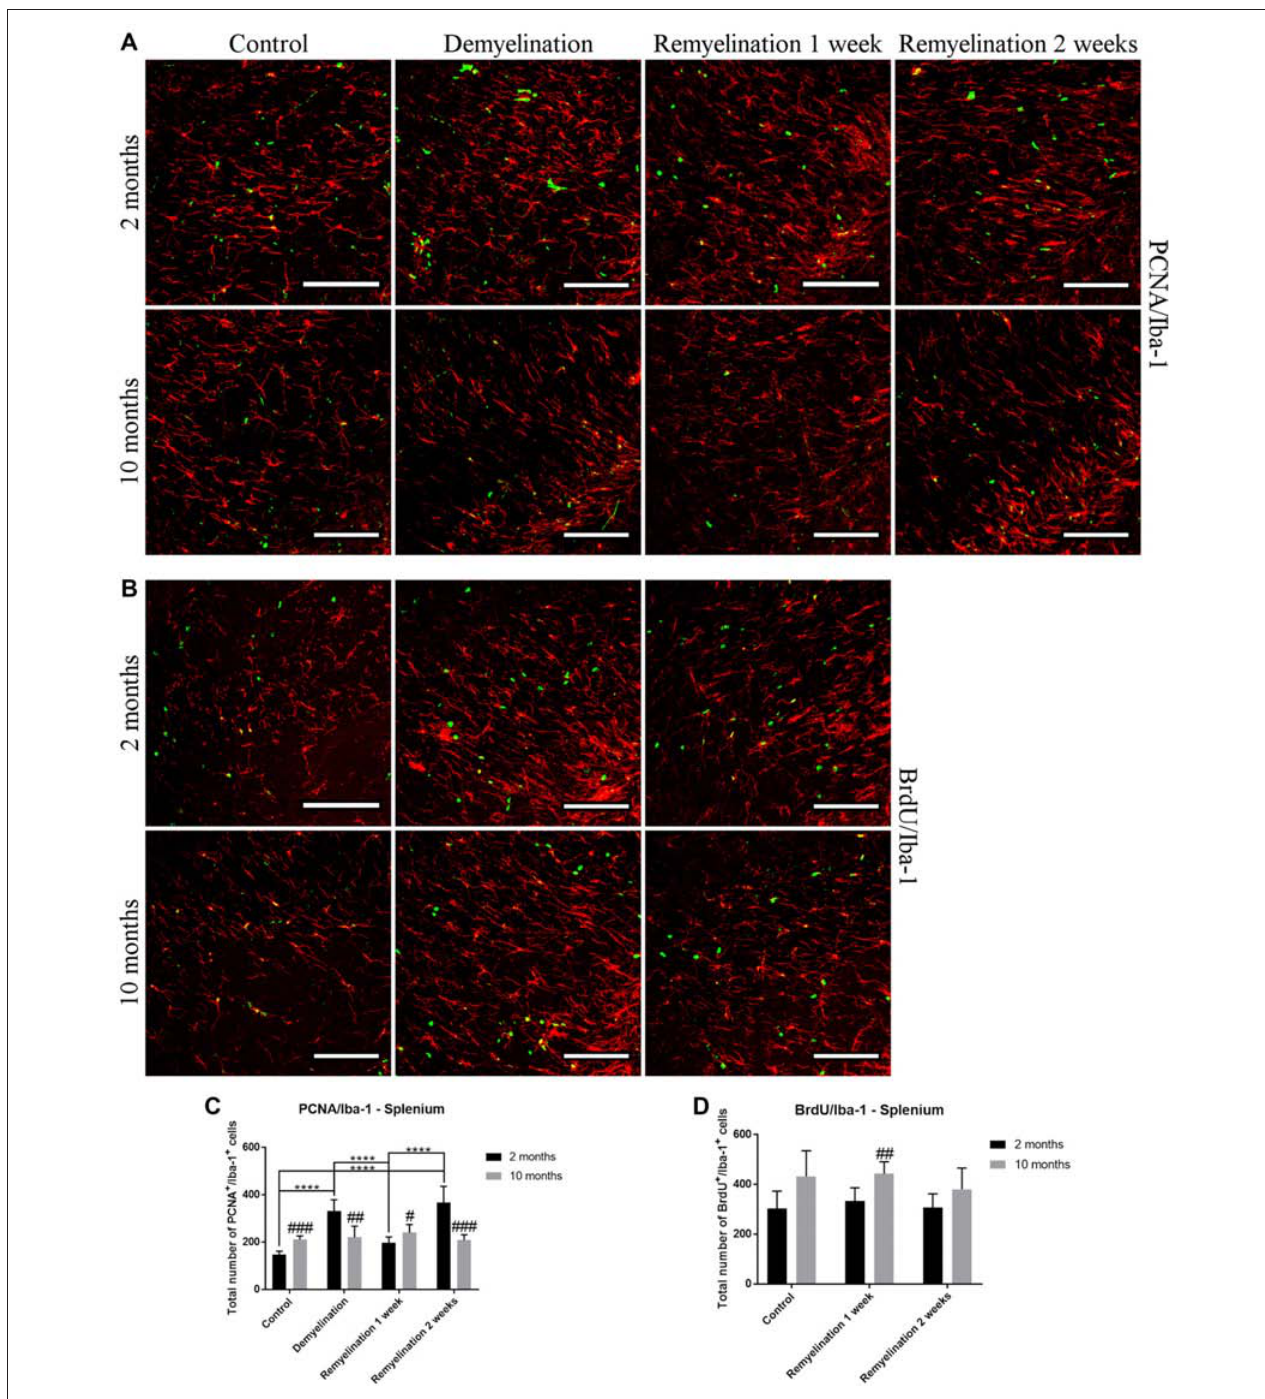
FIGURE 12 | Age-related differences in the number of proliferating microglia (PCNA + and BrdU + ) in the splenium of the CC. (A) PCNA (green) and Iba-1 (red) labeling. (B) BrdU (green) and Iba-1 (red) staining. (C) The number of proliferating PCNA + microglia was significantly increased in the middle-aged control group compared to the younger one. In young mice, there was a significant increase in PCNA + microglia after demyelination and 2 weeks of remyelination. Thus, age-related differences in PCNA + Iba-1 + cell numbers were found in all treatment groups. (D) The number of BrdU + microglia was higher in the middle-aged group after 1 week of remyelination (a similar tendency was also observed in the other two groups). De- or remyelination did not affect the number of BrdU + Iba-1 + microglia. Values are shown as means + SD ( n = 6 per group). Statistical significance was evaluated using a two-way ANOVA and a Tukey’s post hoc test. The p -values are indicated in the graphs: treatment effects within the same age group: ∗∗∗∗ p < 0.0001, age-related differences: # p < 0.05, ## p < 0.01 and ### p < 0.001. Bars: (A) 100 µ m.